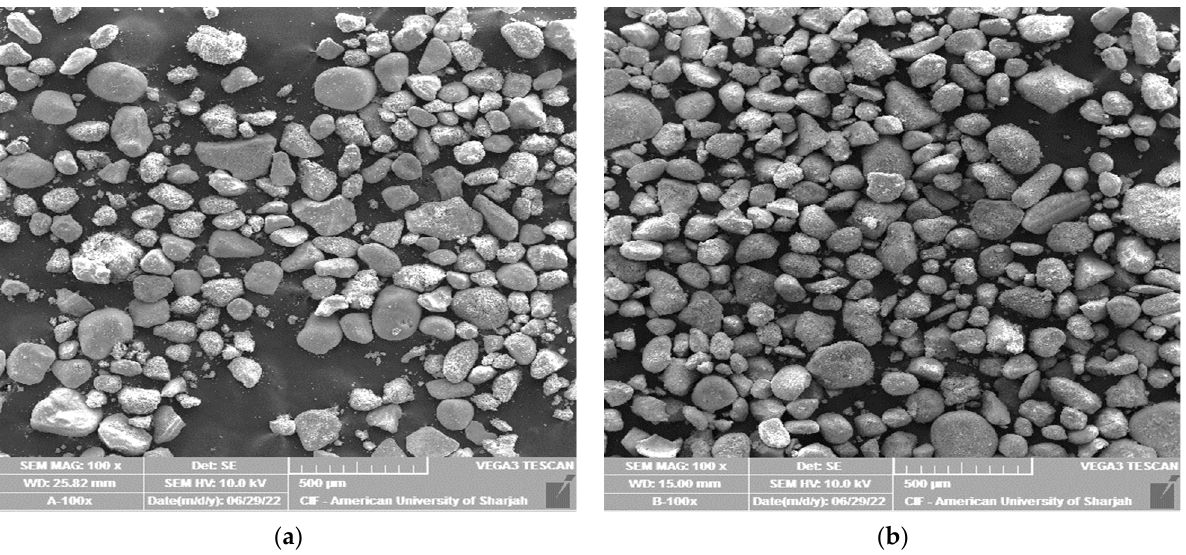
Figure 2. SEM images with a magnification of 100 × of tested soil materials; ( a ) sample A and ( b ) sample B.